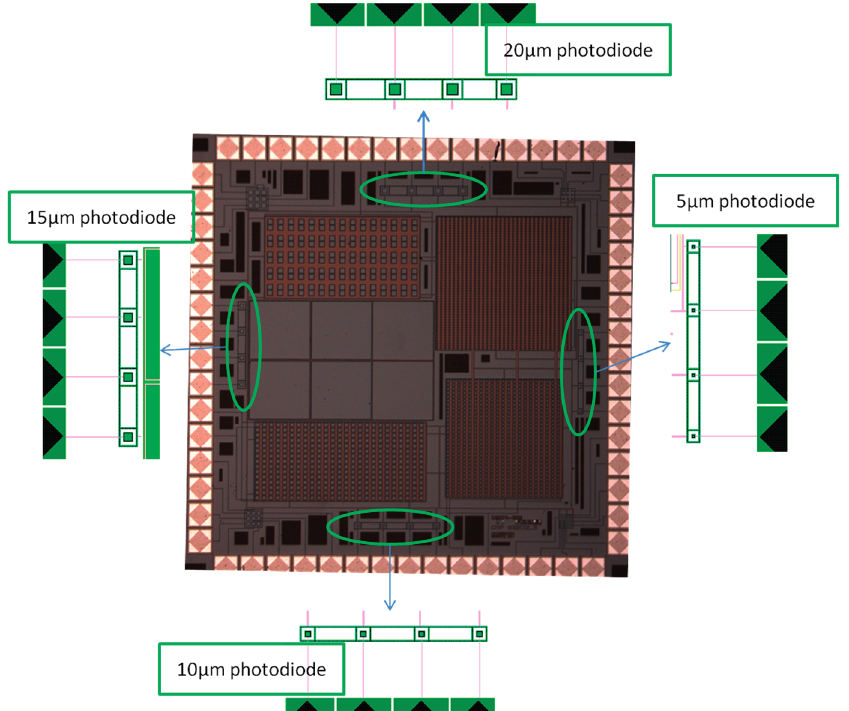
Figure 1. Microphotograph of the chip including zoom on 5 µm, 10 µm, 15 µm, and 20 µm